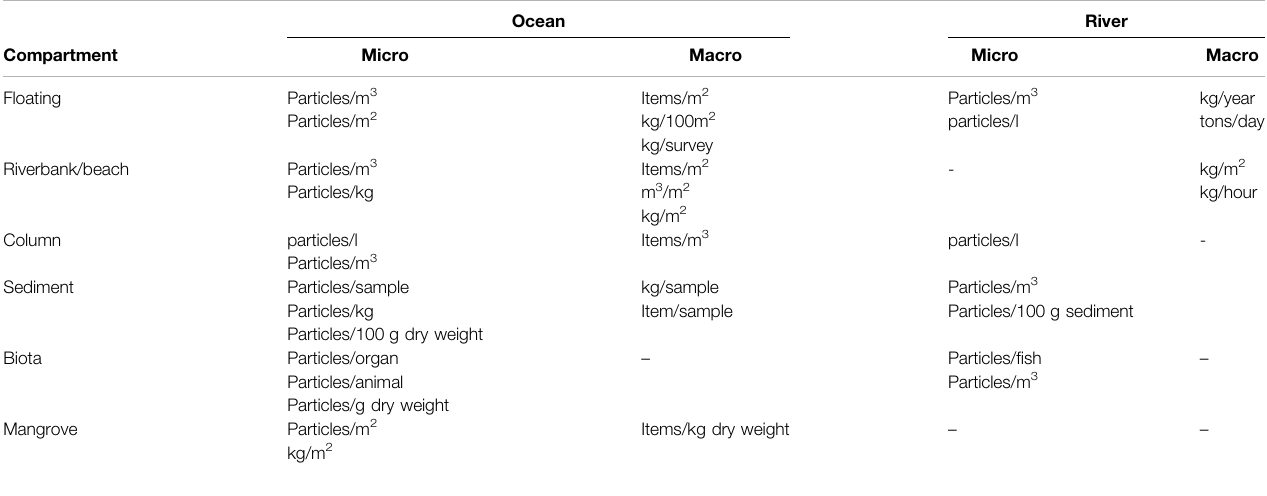
TABLE 3 | Overview of units used to express plastic pollution in marine and riverine systems and each of the environmental compartments, where micro is plastic pollution < 5 mm and macro is plastic pollution > 5 mm. The terrestrial environment was excluded from this table due to the low number of studies performed in this